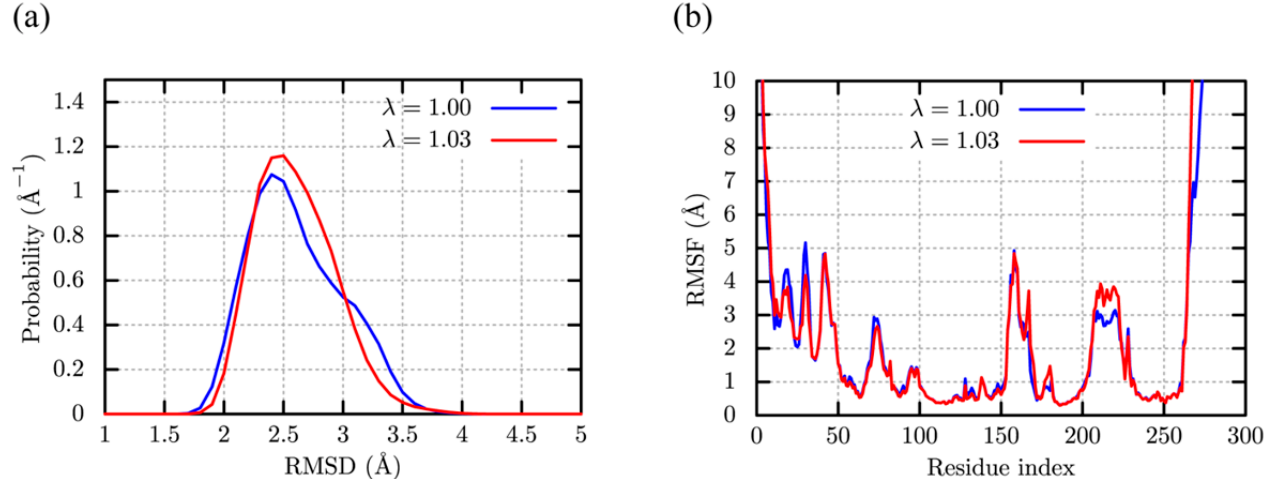
Figure 5. Structural fluctuation of c-Src kinase in water. ( a ) Distribution of C 𝛼 -RMSD. The terminal residues are excluded for the analysis. ( b ) The C 𝛼 root mean square fluctuation (C 𝛼 -RMSF).